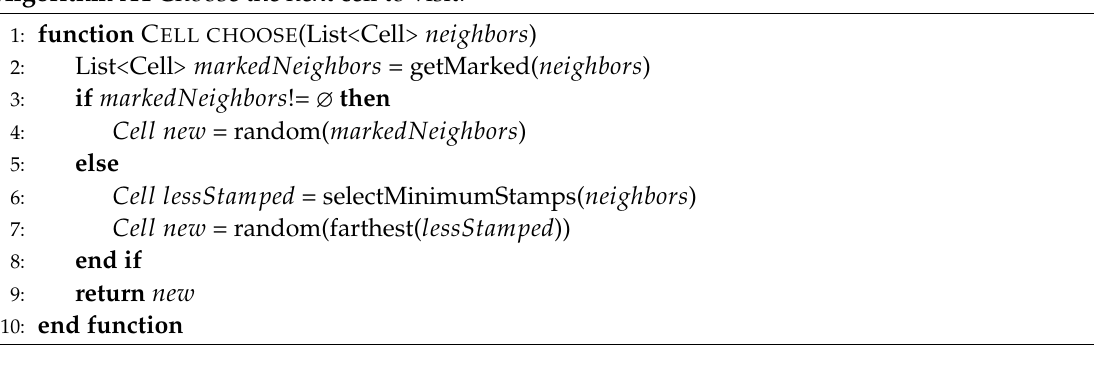
Algorithm A4 Choose the next cell to